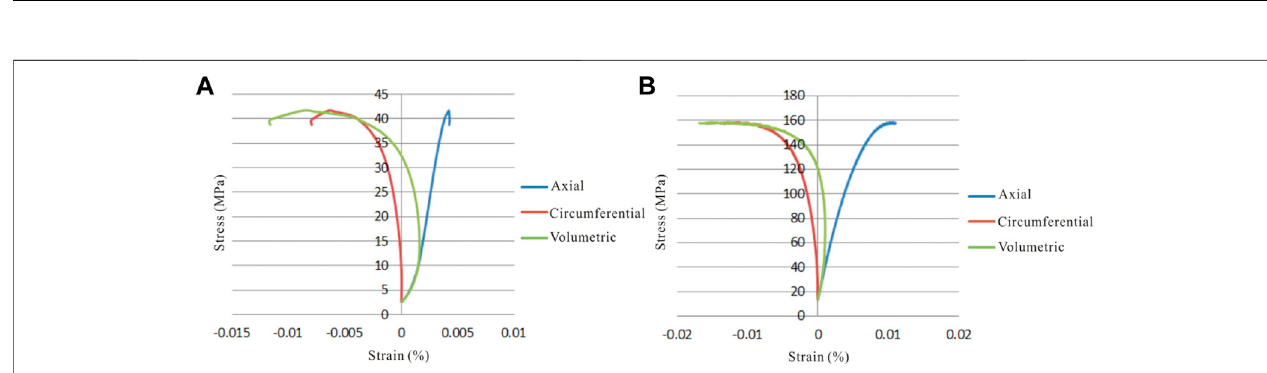
FIGURE 4 | Stress and strain curves of Lc-1 sample in rock mechanics experiments. (A) Uniaxial condition; (B) Con fi ning pressure 35 MPa condition.